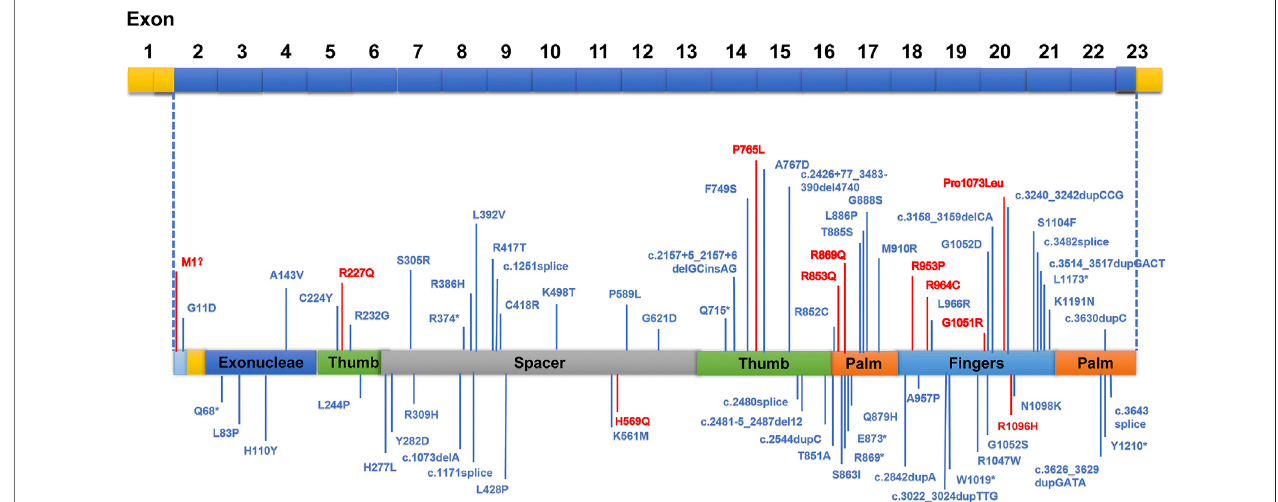
FIGURE1| Areasofdistinguishedvariantsin POLG mutationinAlpers ’ syndrome.Mutationspresentedinredwereidenti fi edinthiscurrentstudy,whereasthosein blue have been reported by past investigations.